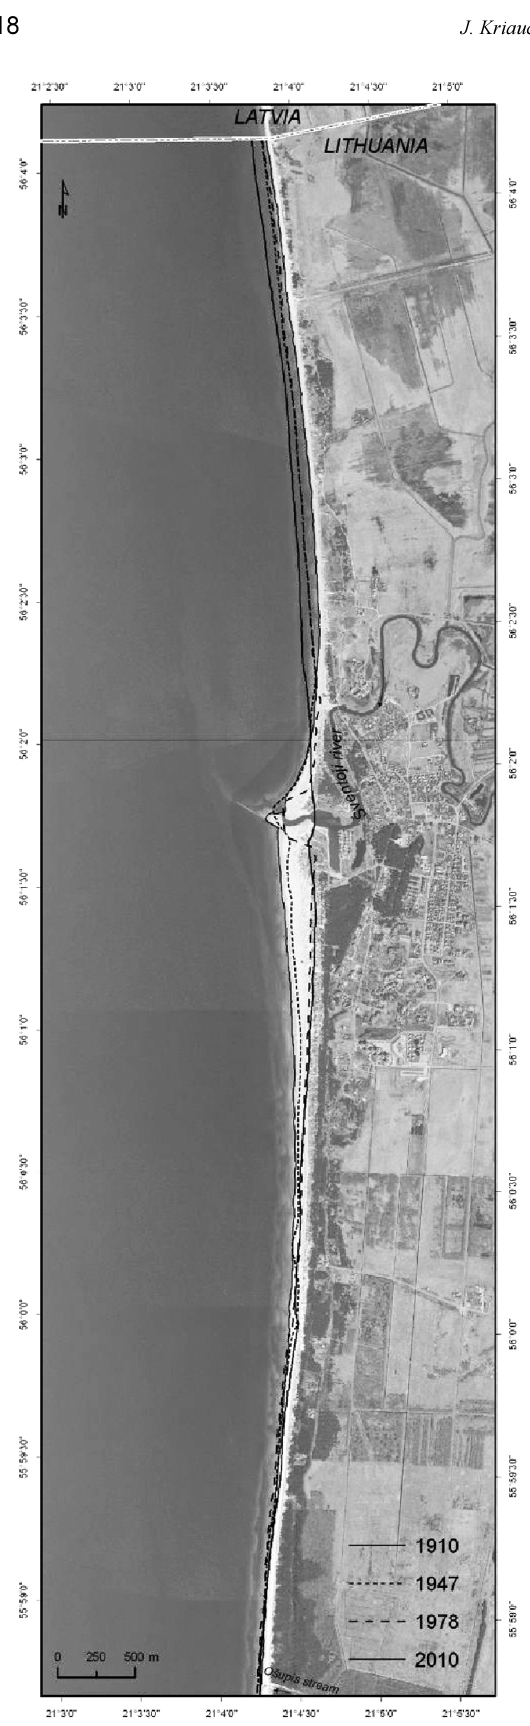
Fig. 3. Coastline changes in the analysed area during the time period from 1910 to 2010